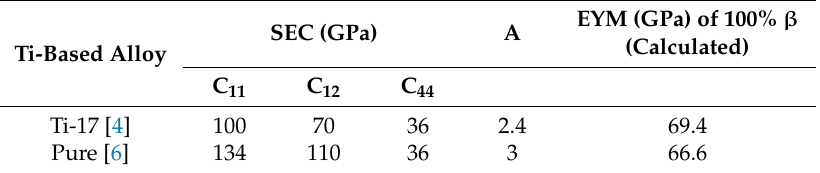
Table 1. β -phase single-crystal elastic constants (SEC) considered in this study, Zener elastic anisotropy factor (A) and effective Young’s modulus (EYM) computed with the purely elastic self-consistent scheme [32,33] for 100% β -microstructure assuming equiaxed grains and random texture.